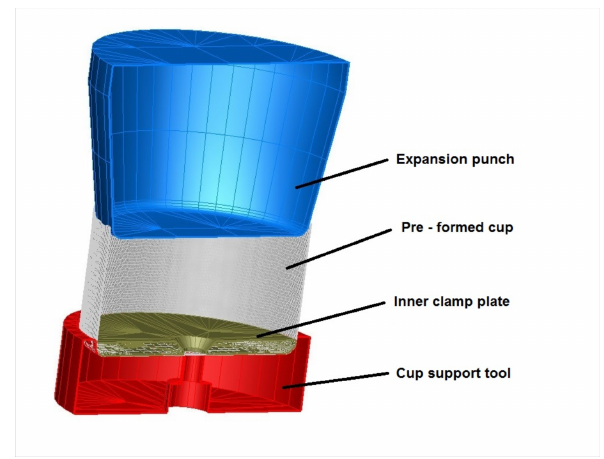
Figure 4: Experimental tool for expansion